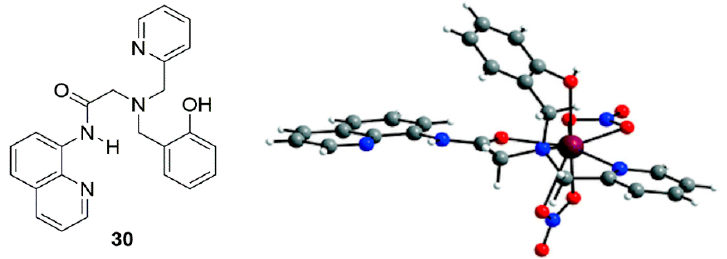
Figure 12. X-Ray crystal structure of [Cd(NO 3 ) 2 ( 30 )]. Adapted from [187] with permission from The Royal Society of Chemistry.